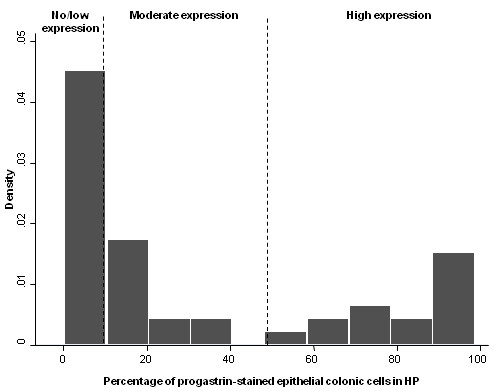
Distribution of percentage of progastrin stained epithelial cells in HP. No/low expression of progastrin was determined using the 95th percentile of percentage of stained cells in normal colonic mucosa (< 10%). Among HP overexpressing the prohormone (> 10%), moderate expression (10%-50%) and high expression (> 50) were distinguished accordingly to the bimodal distribution of progastrin expression.